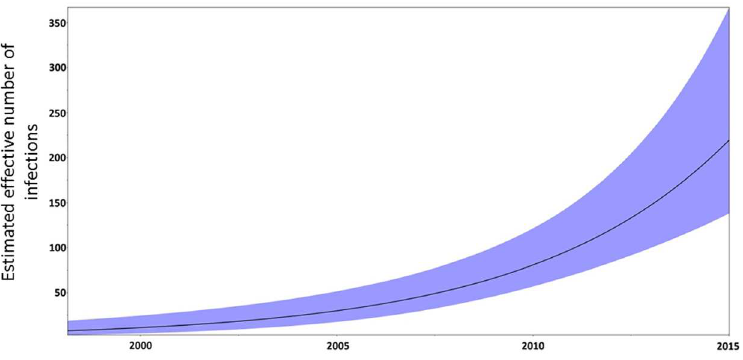
Fig 6. Population dynamics of the 143 sequences from the initial CV cluster. The dynamics was inferred with BEAST, based on the exponential growth model. The black line represents the median estimate of the effective numberof infections, and the shadedarea representsthe 95%